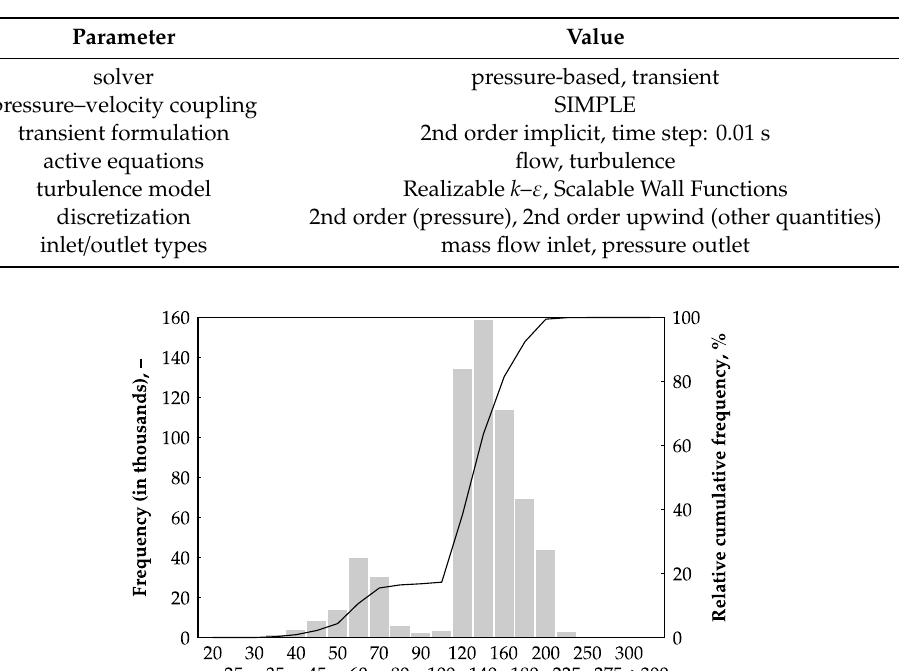
Table 5. Parameters of the simplified 3-D CFD model of the flue gas duct.